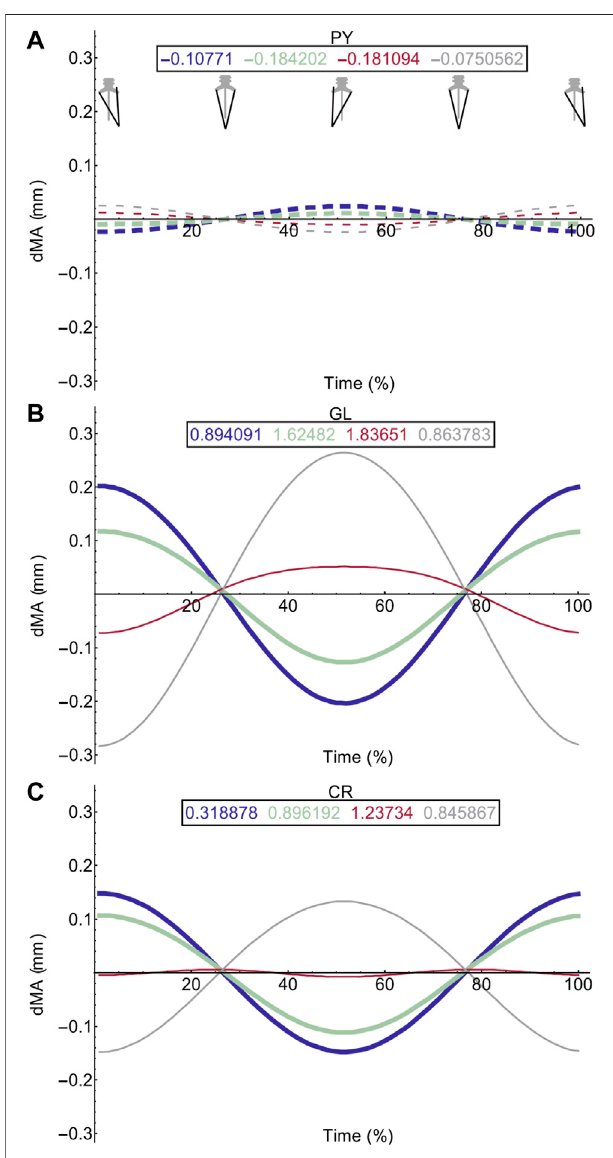
FIGURE 6 | Effect of pelvic rotation on miscellaneous muscle moment arms.Changesin fl exion/extensionmomentarm(dMA)versustimeareshown forpyriformis, PY (A) ,gluteusmaximus,GL (B) ,cruralis, CR (C) .See Figure7 caption for further details. Solid versus dashed lines represent positive moment arms ( fl exion — femur protraction) versus negative (extension — femur retraction) such that a change from solid to dashed indicates a change in muscle function.